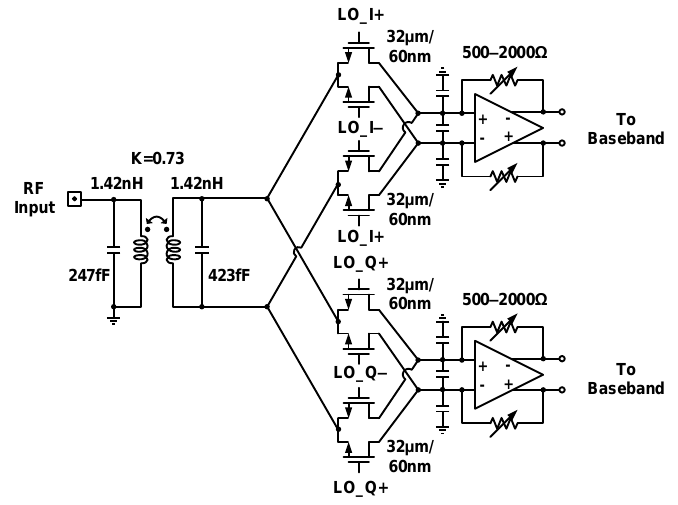
Figure 6. Circuit schematic of the mixer-first receiver front-end.